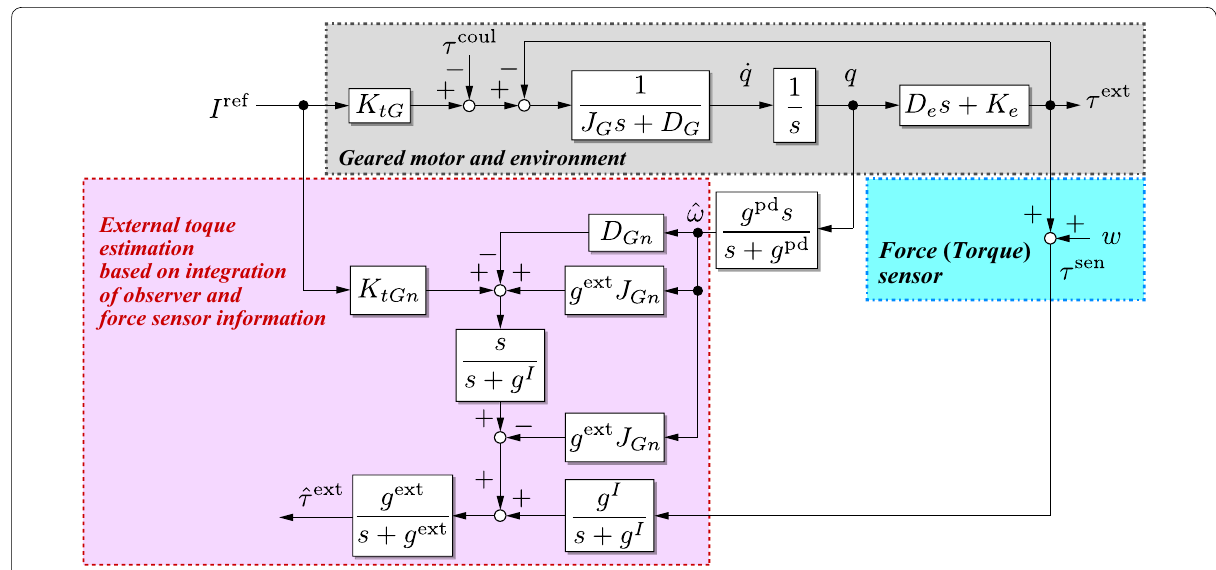
Fig. 2 Block diagram of the proposed external torque estimation